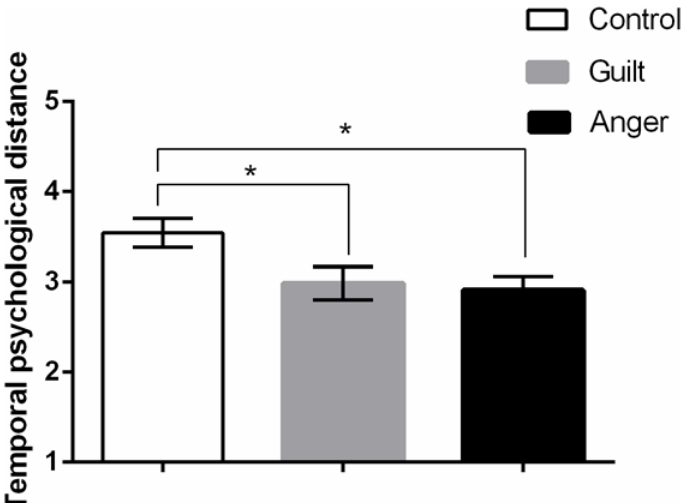
Fig 1. Means and SEMs for perceptions of psychological distance in Study 2 ( N = 278). Higher scores indicate greater temporal psychological distance. Participants who wrote about anger- or guilt-inducing transgressions perceived the event as being closer in time than participants who wrote about a neutral event. The two emotion conditions did not differ in perceived psychological distance. * p < .05.